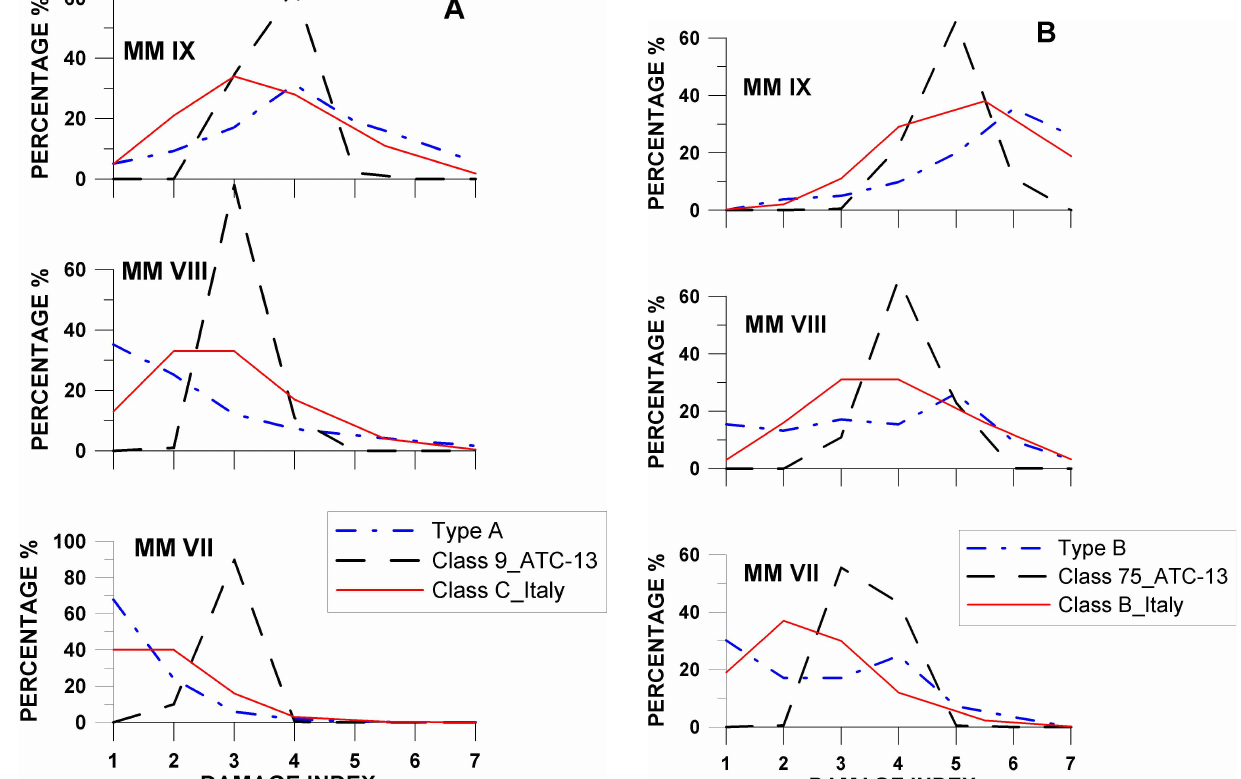
Fig. 11. Comparison between the DPM-2007, DMP Italy (Dolce et al., 2003) and the PDM-ATC-13 (ATC-13, 1985) curves proposed for similar types of buildings. (A) , for type A, class C Italy and class 9-ATC-13; (B) , for type B, class B Italy and class